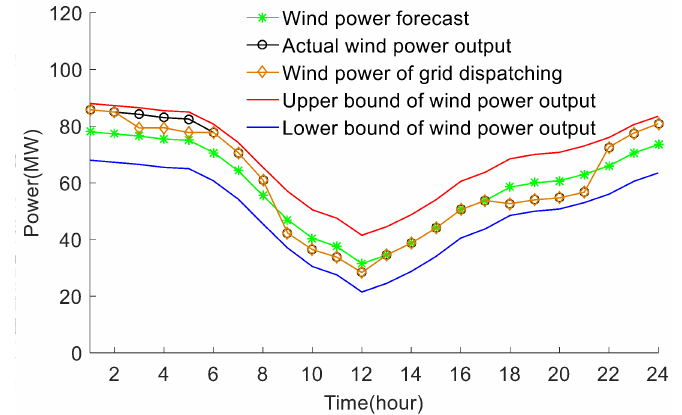
Figure 8. Related output of wind power and its upper and lower